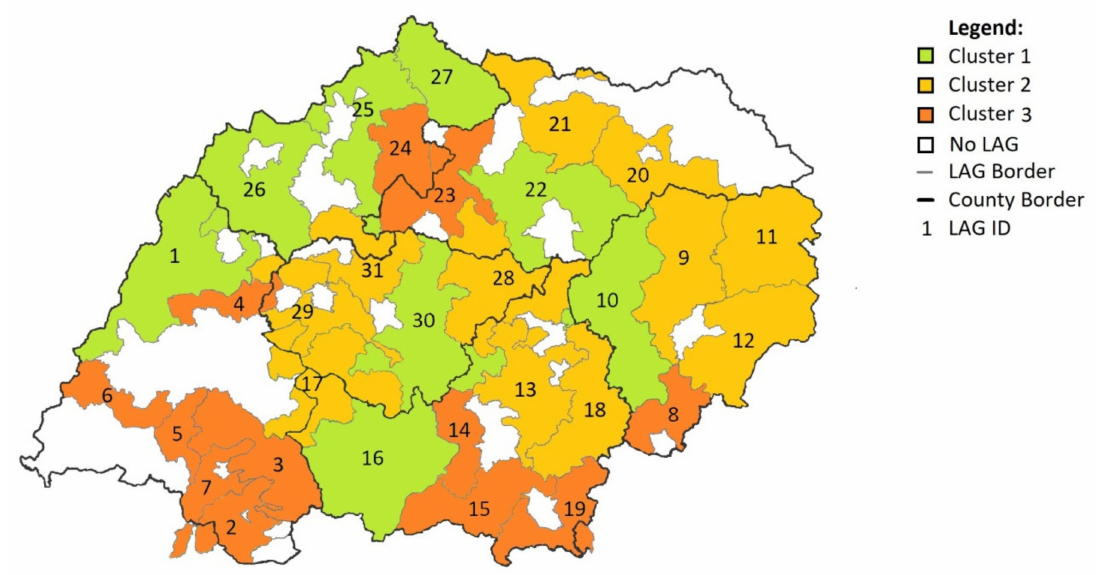
Figure 2. Source: own analysis. Extraction method: cluster analysis. Squared Euclidean distance. Ward